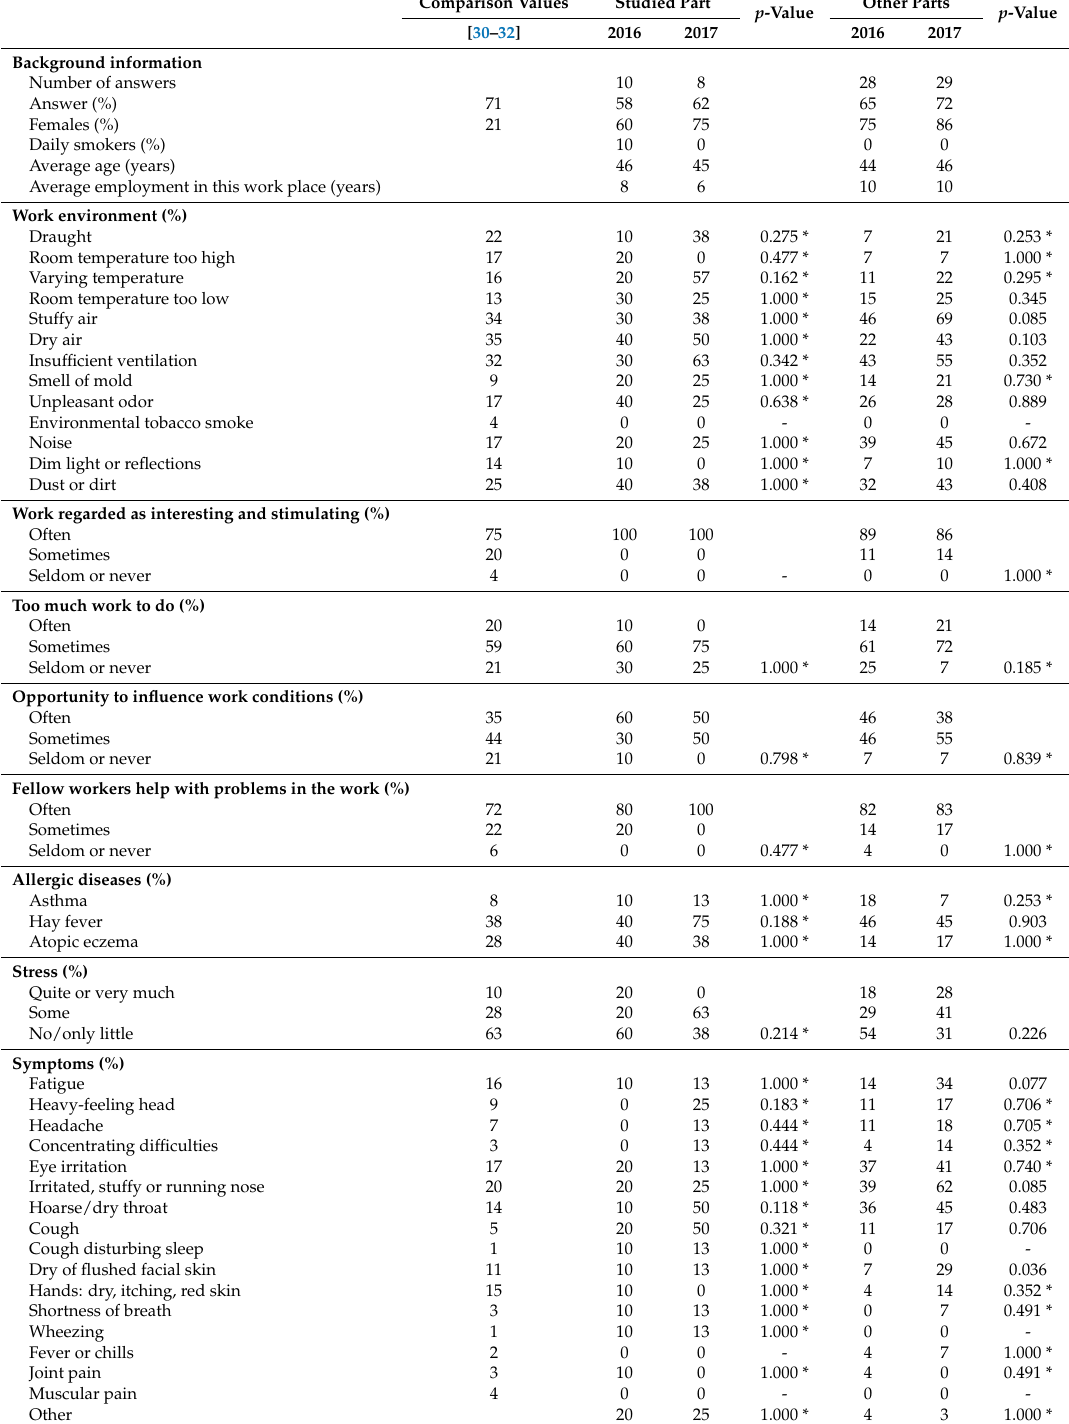
Table 9. Indoor climate questionnaire (Finnish Institute of Occupational Health © 2006–2008, version 2.0) results from spring 2016 and winter 2017. Statistically significant changes at a 10% confidence interval ( p < 0.1) are bolded. p -values marked with * were determined by the Fisher’s exact test (SPSS). Comparison values are based on the analysis of comprehensive questionnaire data collected by